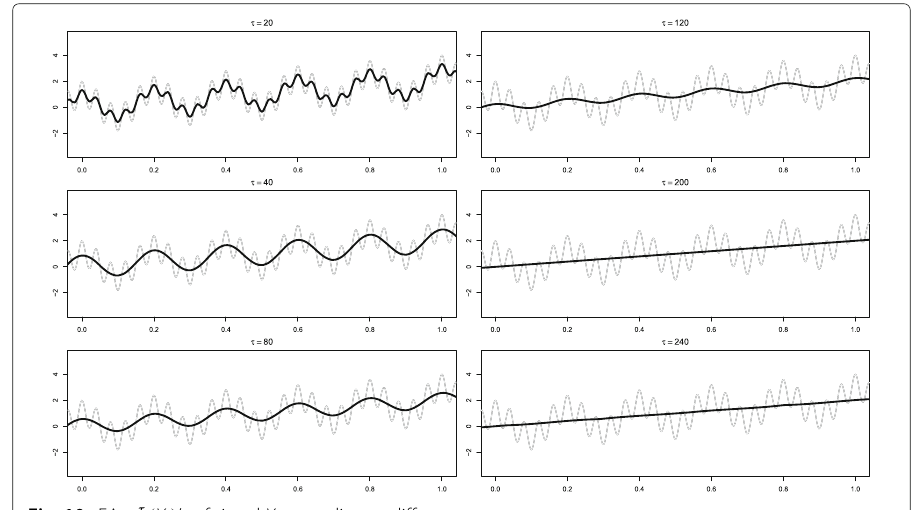
Fig. 10 EAve τ t ( X t ) ’s of signal X t according to different τ